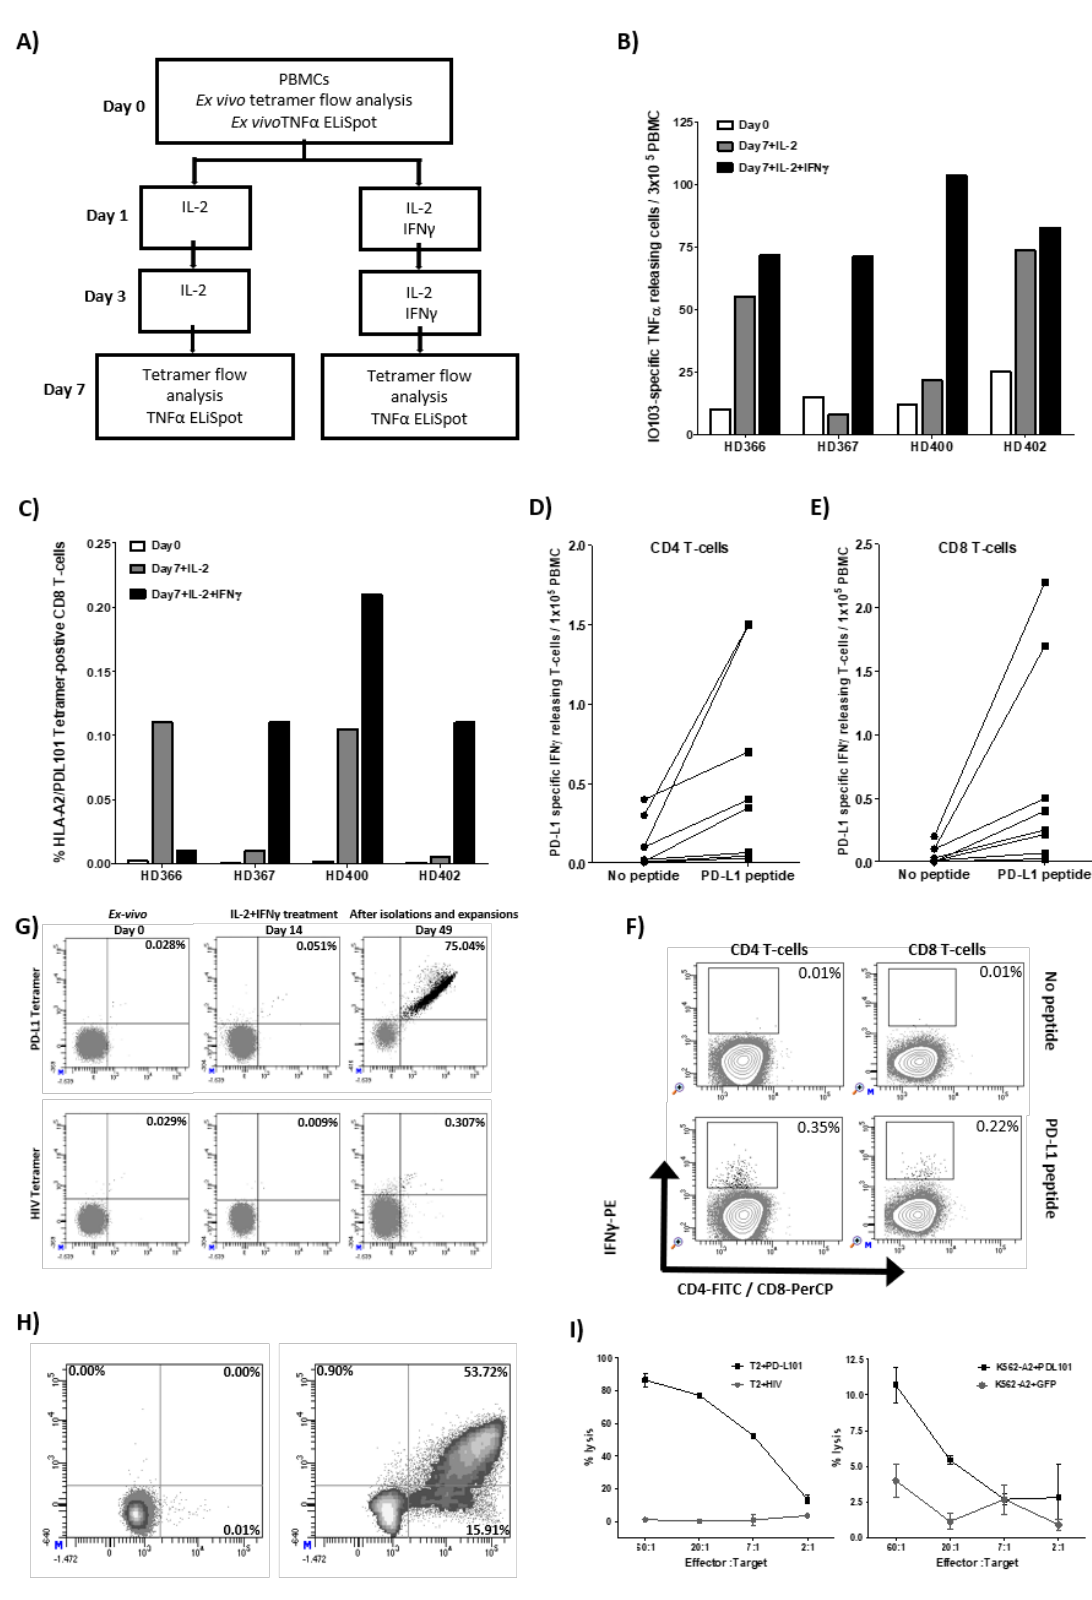
FIGURE 1: Pro-inflammatory cytokines induce expansion of PD-L1-specific T cells in vitro. (A) Experimental set up: PBMCs from four healthy donors were stimulated twice with IL-2 with or without IFN- γ . On day 7, cultures were examined for T-cell reactivity towards PD-L1 by either tetramer flow analysis or TNF- α